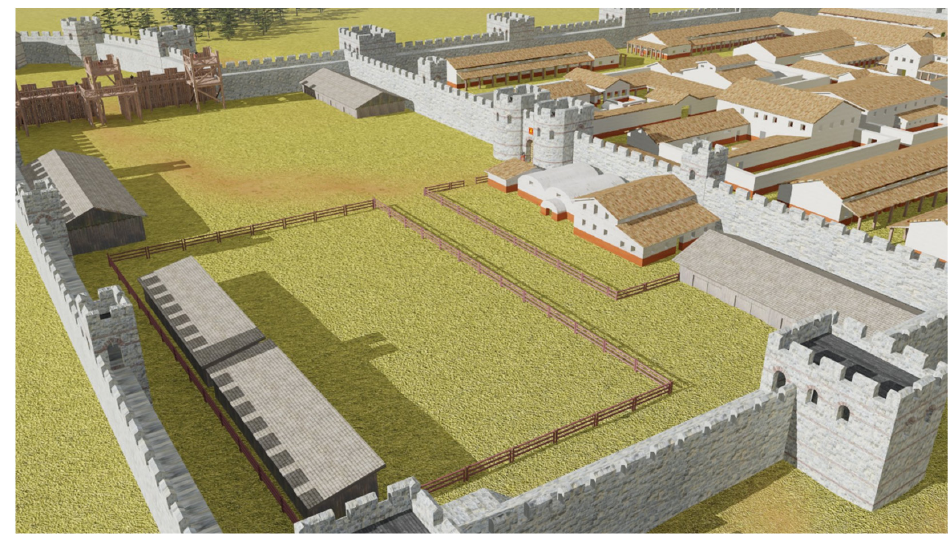
Figure 7. Reconstruction of the central part of the fortress (area 2).